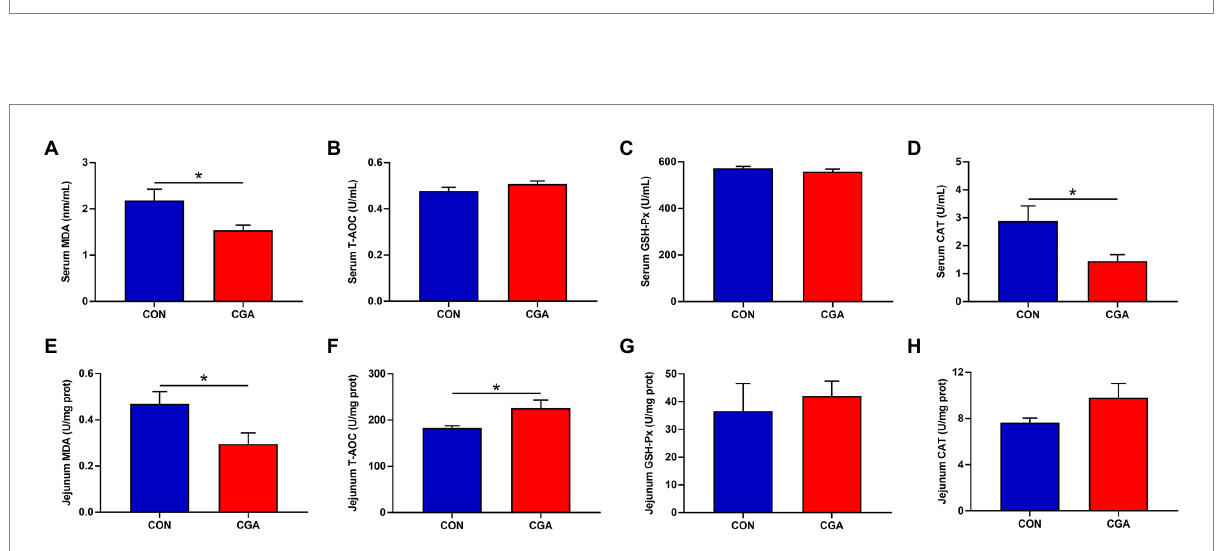
FIGURE 4 Effects of CGA on the levels of antioxidant indicators in the serum (A–D) and jejunum (E–H) of weaned rabbits. MDA, malondialdehyde; T-AOC, total antioxidant capacity; GSH-Px, glutathione peroxidase; CAT, catalase; CON, rabbits fed a basal diet; CGA, rabbits fed the basal diet supplemented with 800 mg/kg chlorogenic acid. Results are presented as mean and SEM ( n = 8). Significant difference was recorded by 0.01 < p <